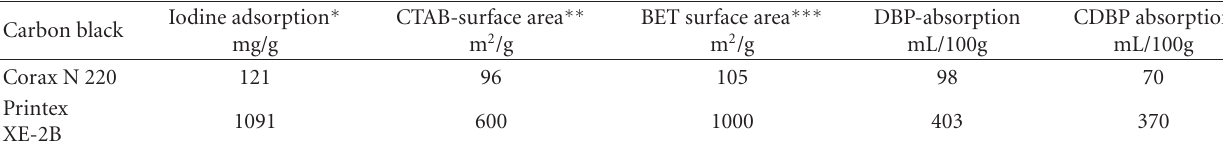
Table 1: Typical properties of the carbon black